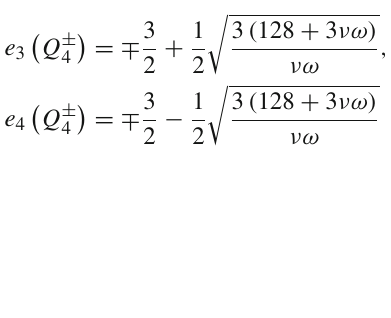
at the finite regime. First row are plots for ω = − 1 while in the second row are plots with ω = − 5 . The plots of the left and right columns are is an attractor the same but from a different view 4